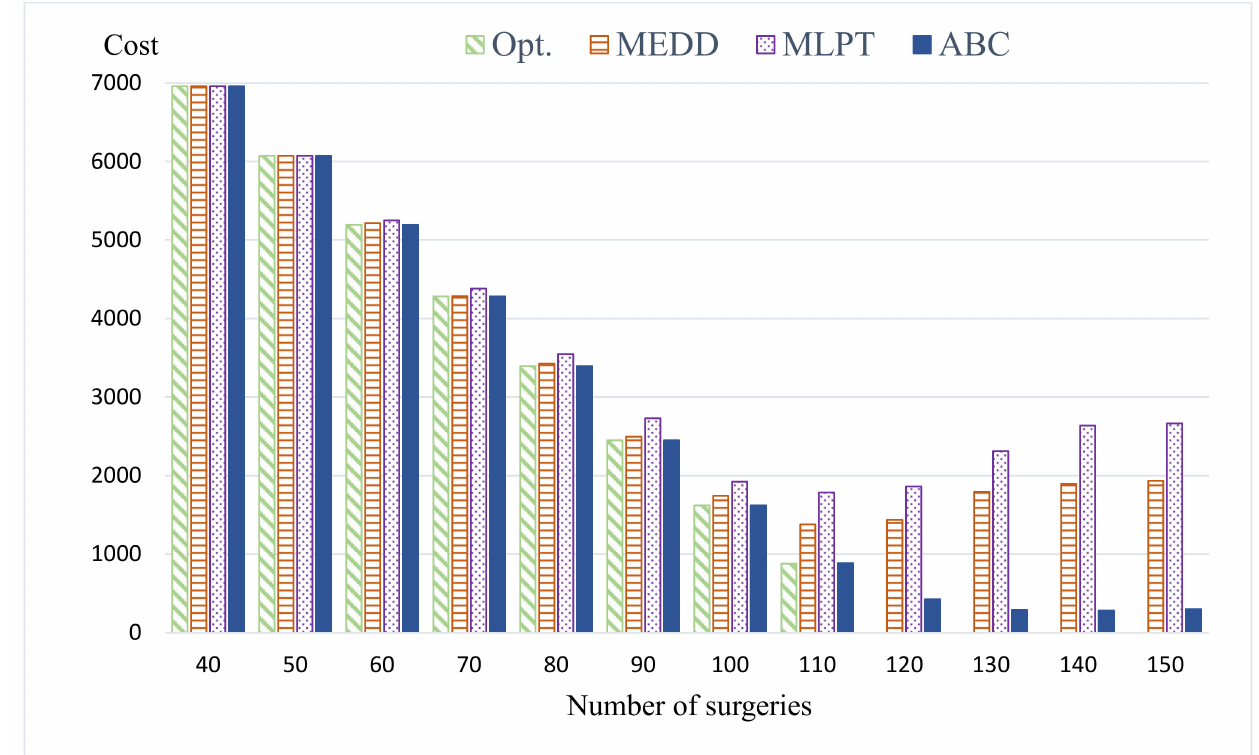
Figure 4. Comparison of four methods.